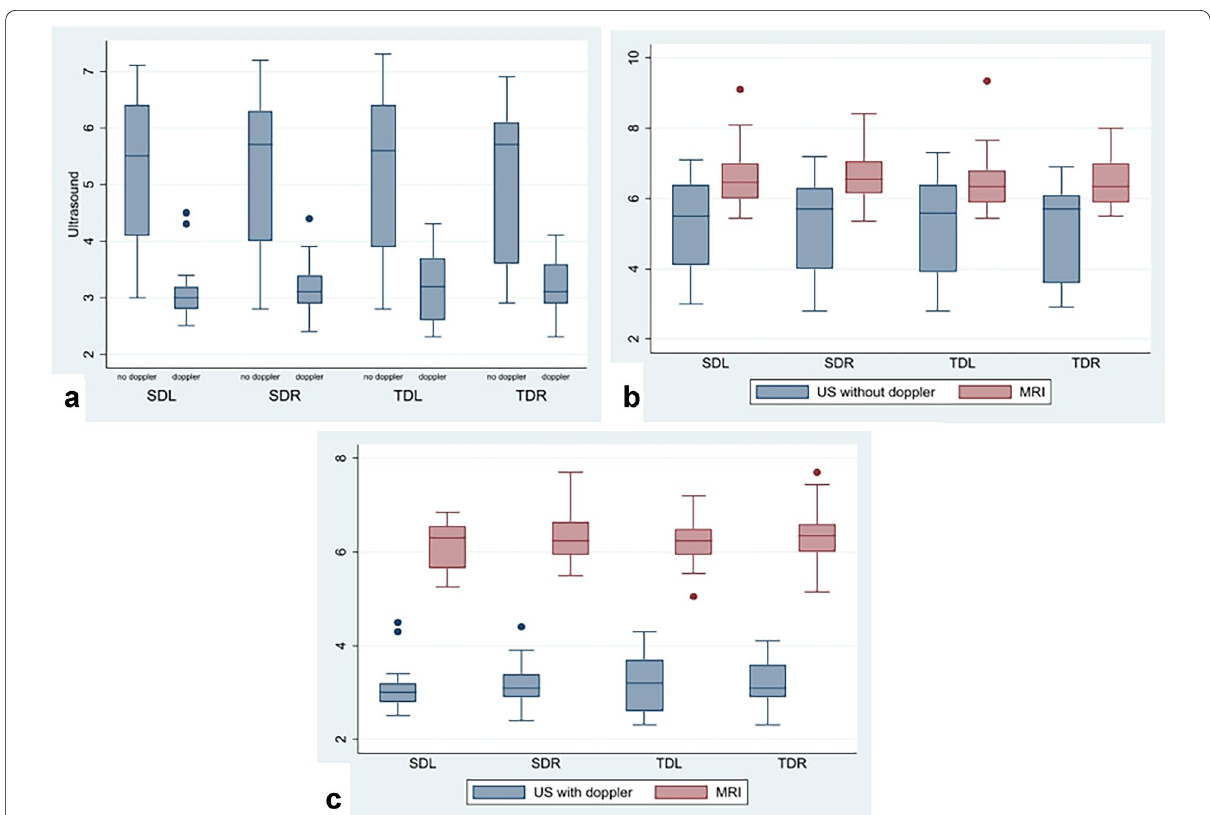
Fig. 3 The values in the reported axes are in millimeters. a Color-Doppler measurements are less scattered and significantly lower than those in B-mode. b MRI vs B-mode (without Doppler) in 27 patients; c MRI vs color-Doppler mode in 23 patients; box plots show a clear difference in comparison between the MRI and the two US modalities, highlighting an evident difference in all the analyzed diameters. SDL sagittal diameter left,